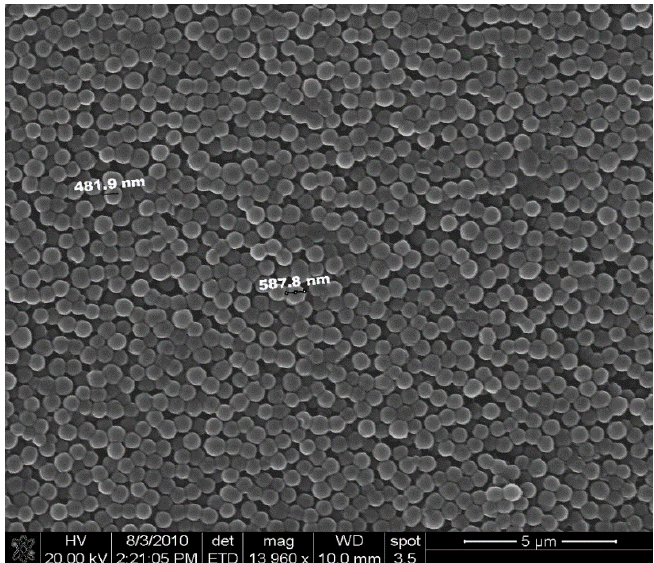
Figure 14. Scanning electron micrograph of polymer particles of M-70 (15 millimoles of N